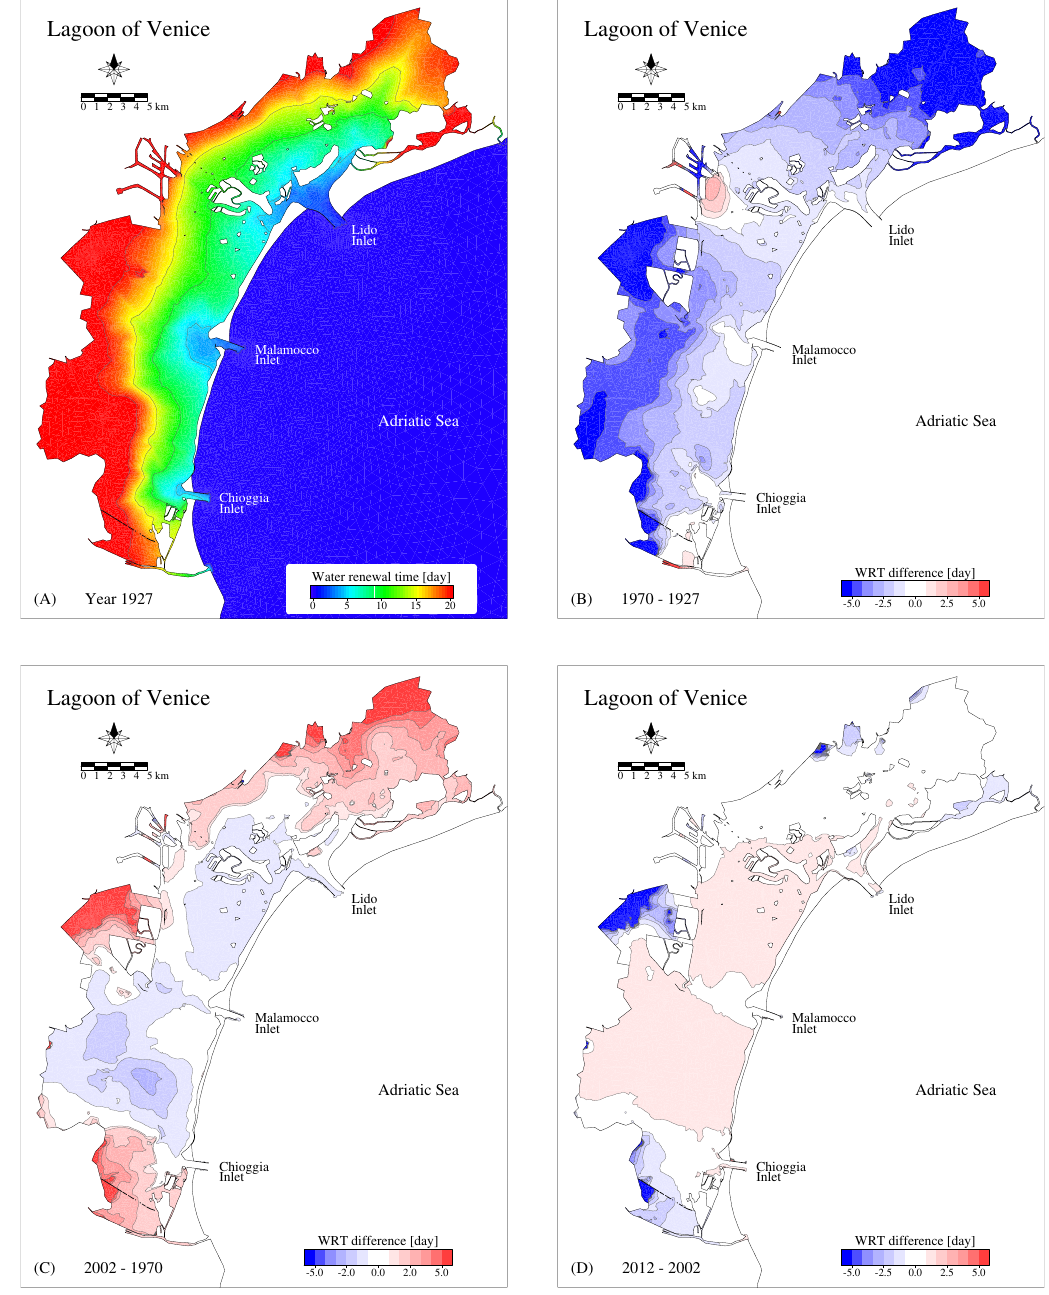
Fig. 4. Map of water renewal time computed by the model for the 1927 (A) and maps of the WRT difference (in days) between 1970 and 1927 (B) , between 2002 and 1970 (C) and between 2012 and 2002 (D) . WRT values were computed as average of four replicas obtained by forcing the model with water level and wind observations of year